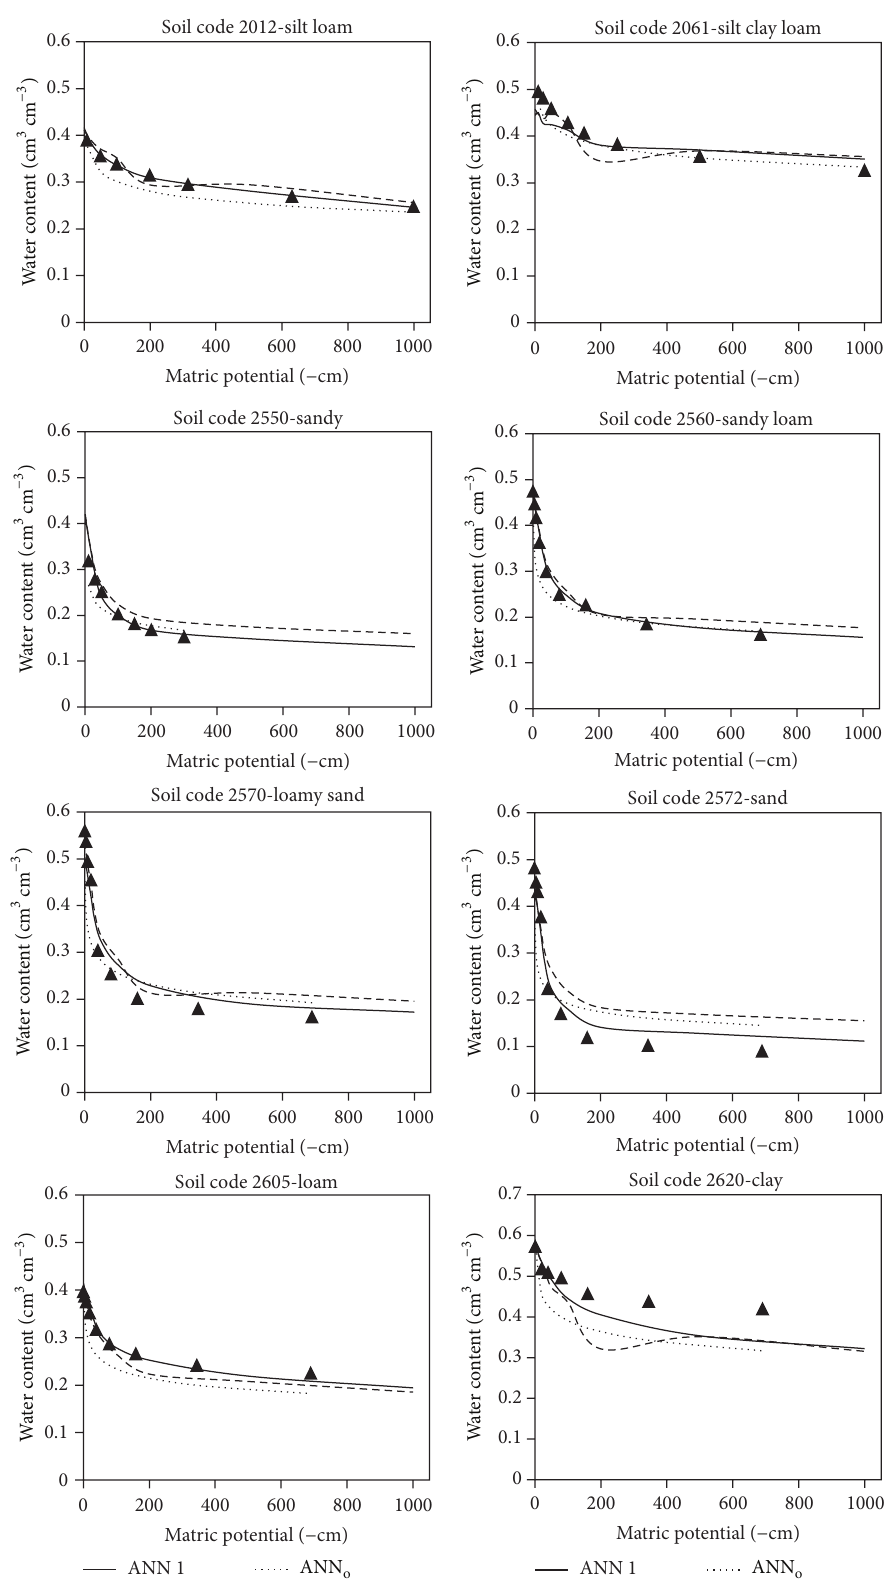
Figure 8: Observed and predicted soil water retention curves given by ANN models developed in this